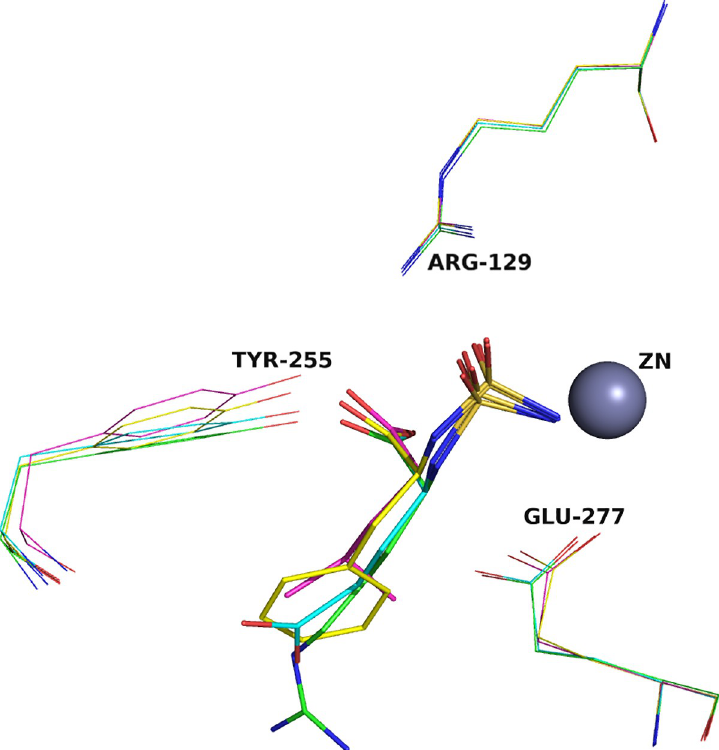
Fig 1. The nature of the inhibitor’s side chain influences on the conformation of the transition complex of CPT. Superposition of CPT complexes with SArg (green), SPhe (yellow), SLeu (cyan), SGlu (magenta) is shown. Zinc ion is represented as the gray sphere, amino acid residues of the catalytic site of the CPT’s active center are shown by wire models.